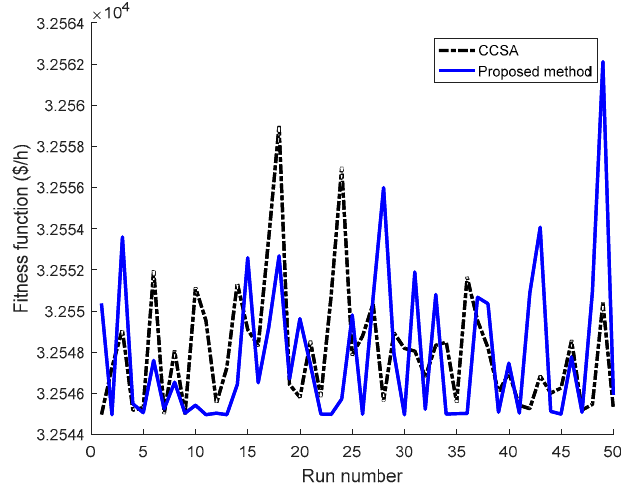
Figure 8. Fitness function of 50 runs obtained by the CCSA and proposed method in case 2. Table 5. The result comparison about cost ($/h) between methods in case 1.